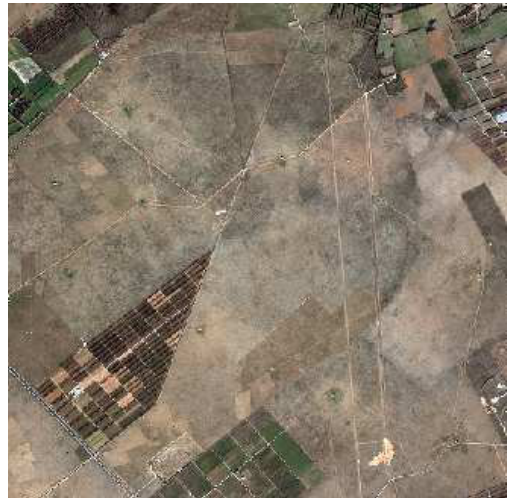
Figure 5: La Crau acquired by PLEIADES the 01/24/12.